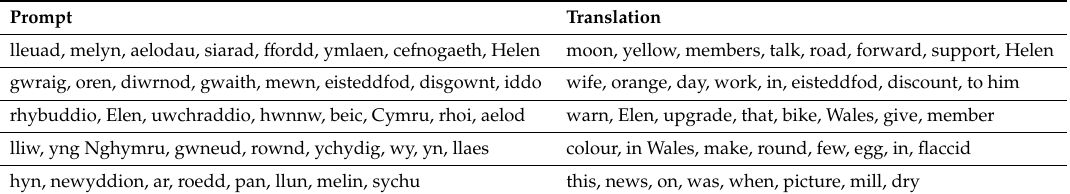
Table 1. Examples of individual word prompts with English